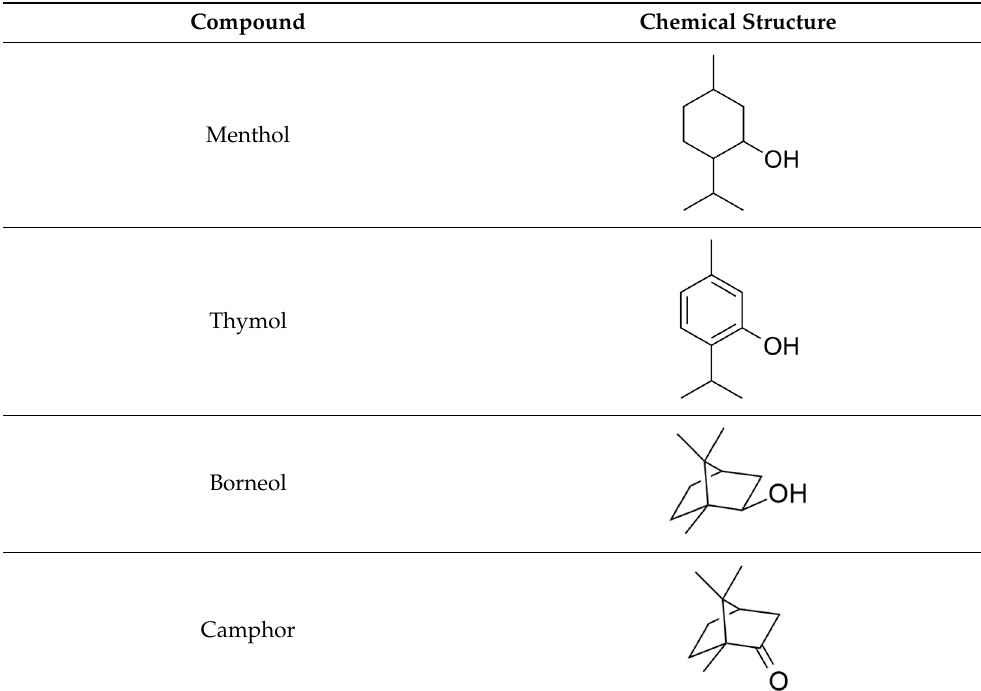
Table 1. Chemical structure of the Table 1. Chemical structure of the terpenes Table 1. Chemical structure of the terpenes Table 1. Chemical structure of the terpenes Table 1. Chemical structure of the terpenes.